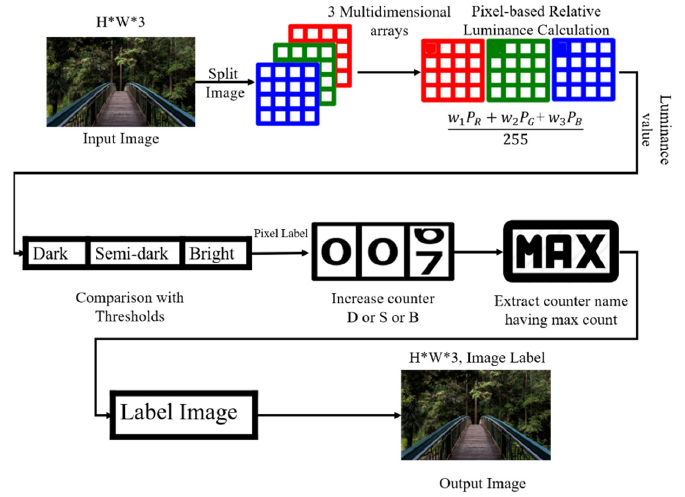
Figure 7. Support Vector Machine (SVM) Classification Pipeline.